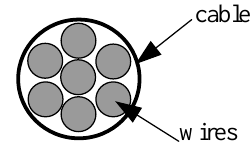
Figure 2. Cross-section of cable CFCC ϕ 12.5.